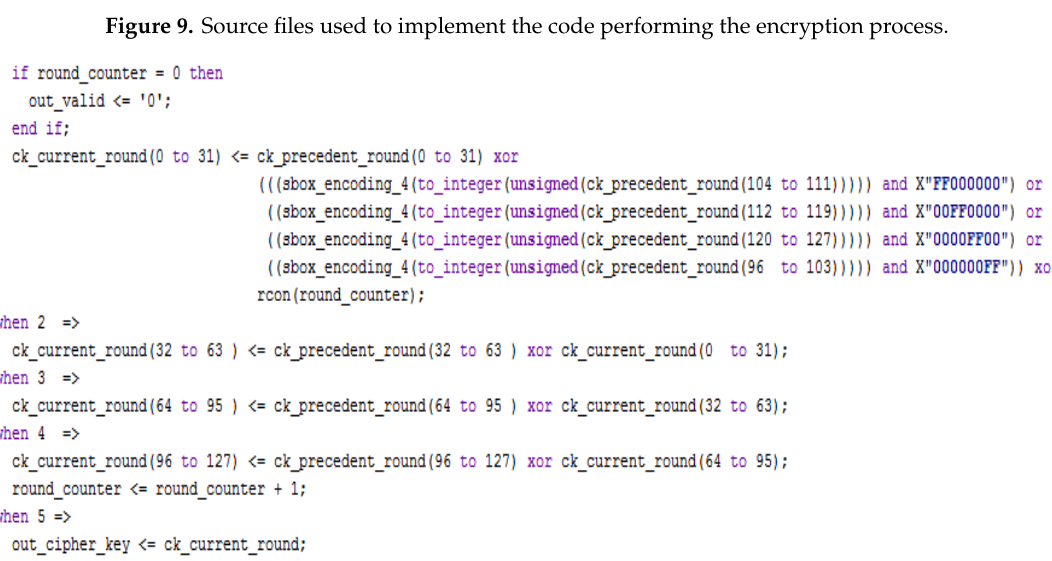
Figure 10. Code section used to generate the 10 subkeys, for encrypting the 128-bit plaintext data packets.